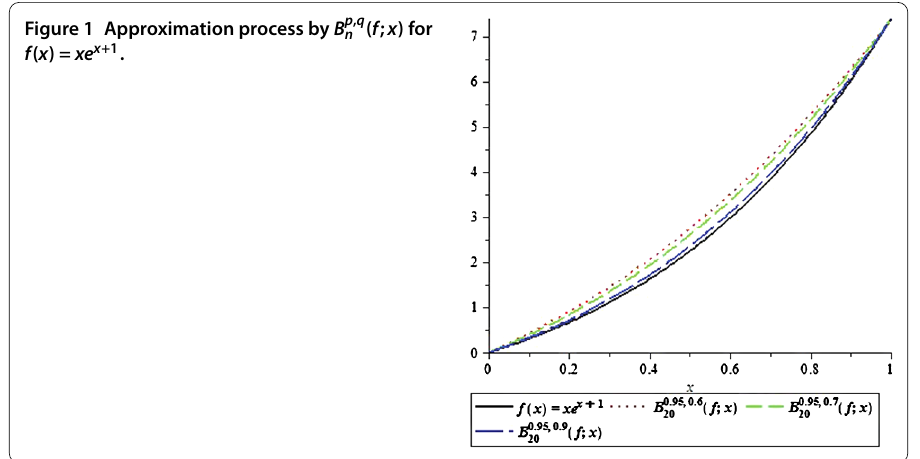
Figure 1 Approximation process by B p , q n ( f ; x ) for f ( x ) = xe x +1